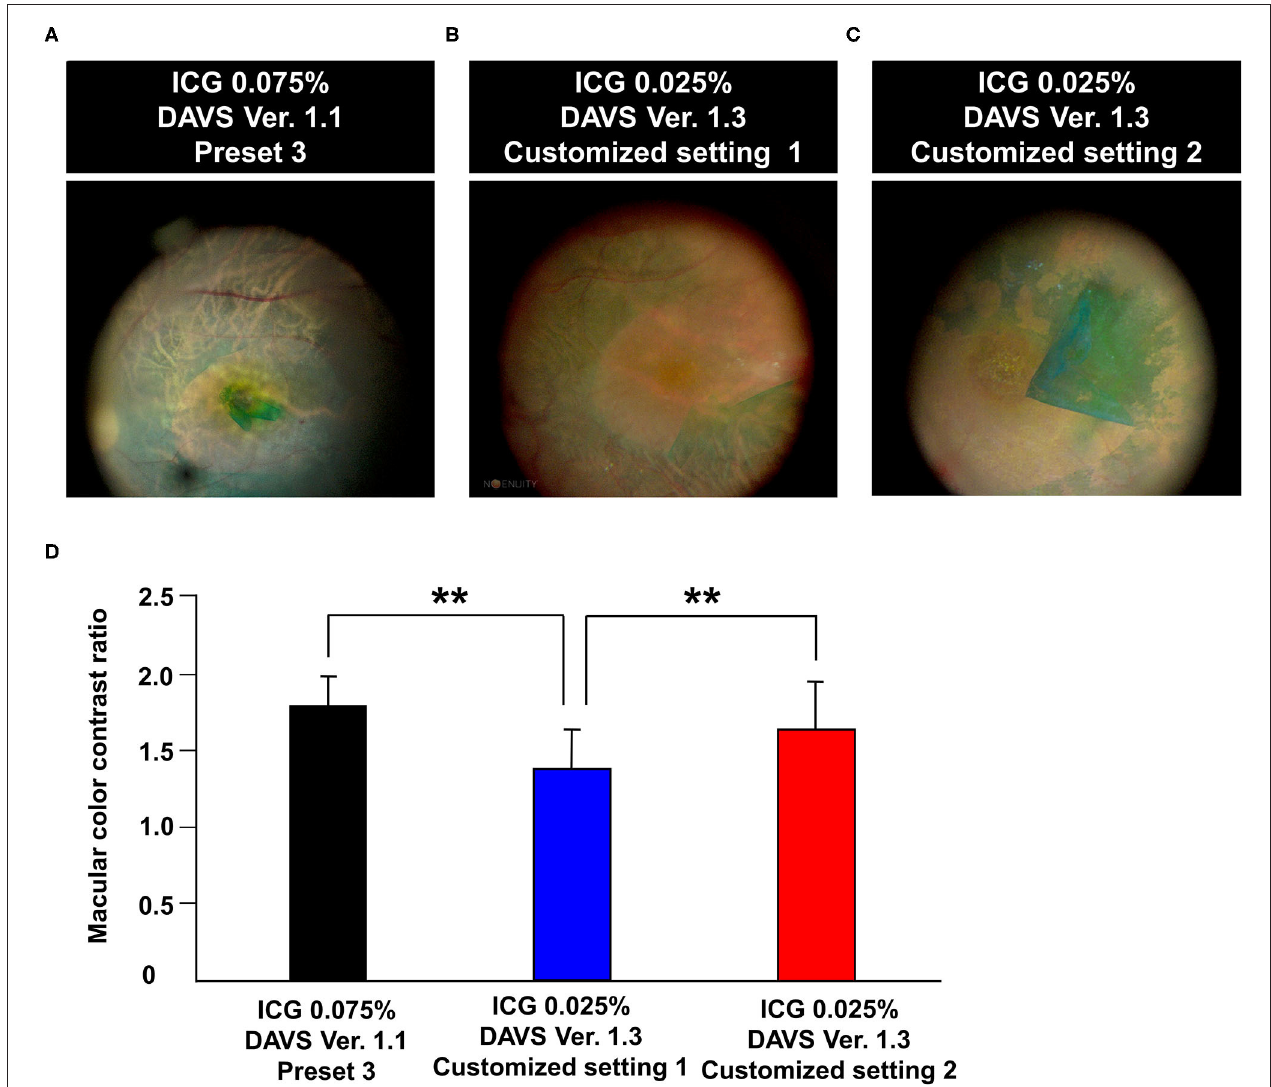
FIGURE 3 | Comparison of color contrast ratio (CCR) using different color settings of digitally assisted vitreoretinal surgery system (DAVS) in different indocyanine green (ICG) concentrations. (A) Macular image captured using Preset 3 of DAVS Ver. 1.1 with 0.075% ICG. (B,C) Macular image captured using Customized Settings 1 and 2 of DAVS Ver. 1.3 with 0.025% ICG. (D) CCR of Customized Setting 2 of DAVS Ver. 1.3 with 0.025% ICG did not differ from that of Preset 3 of DAVS Ver. 1.1 with 0.075% ICG ( P = 0.887). ** P <